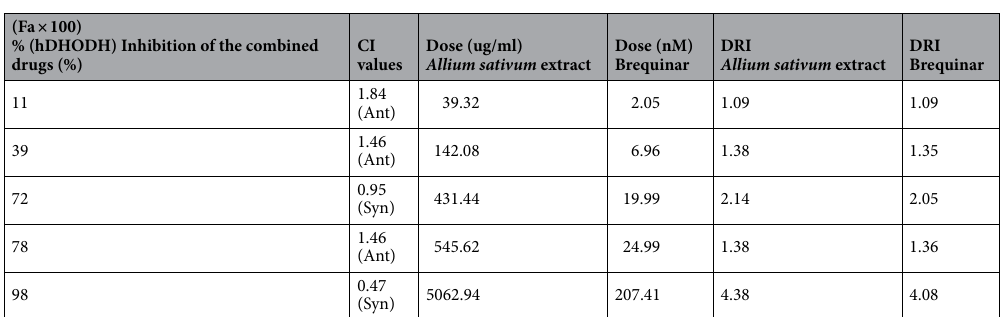
CI Dose (ug/ml) values Allium sativum extract